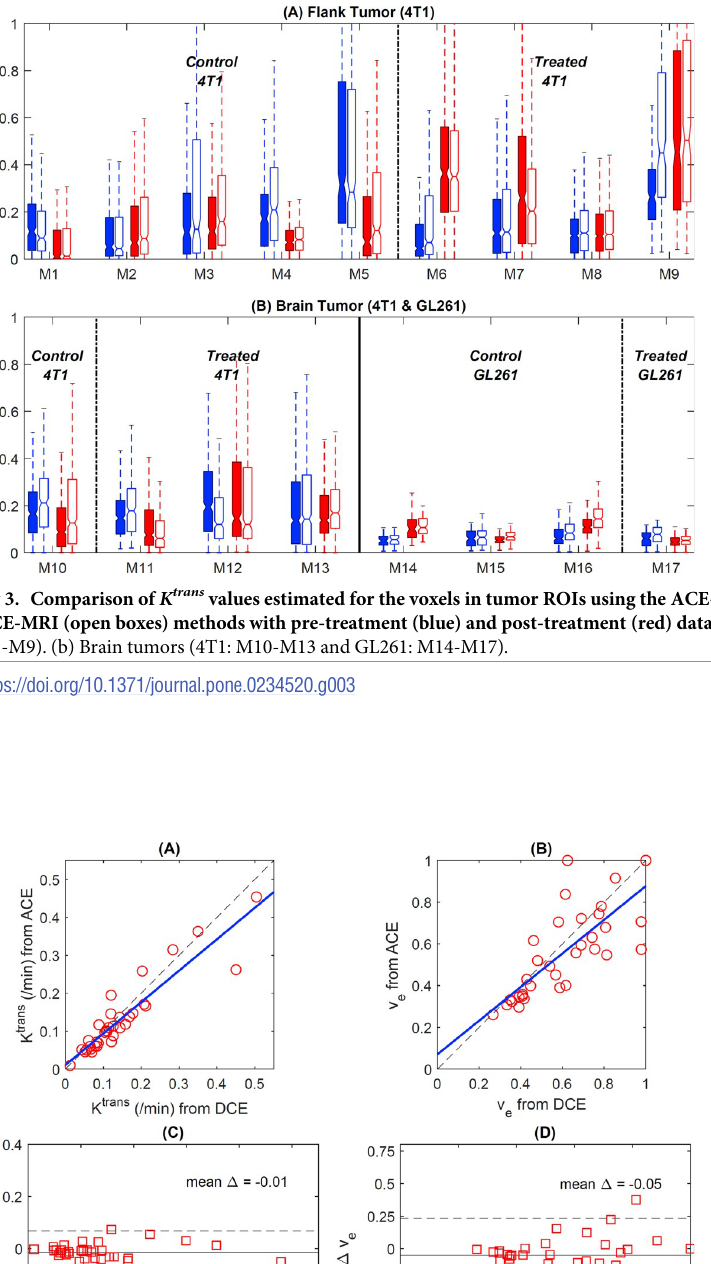
pre/post-treatment (d). Solid thin e